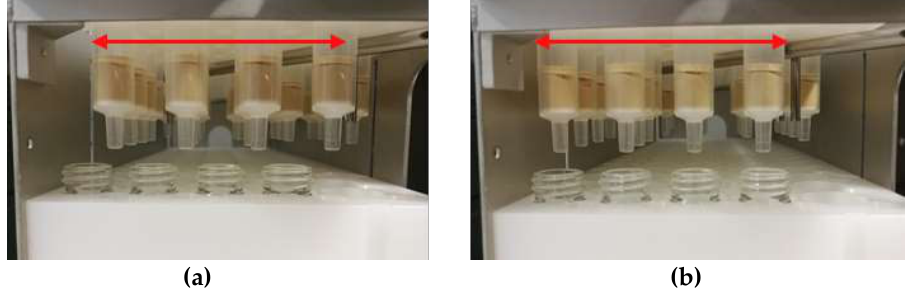
Figure 8. Representation of the SPE rack ’s functionality: ( a ) Position A: conditioning and sample in- troduction; ( b ): Position B: elution.